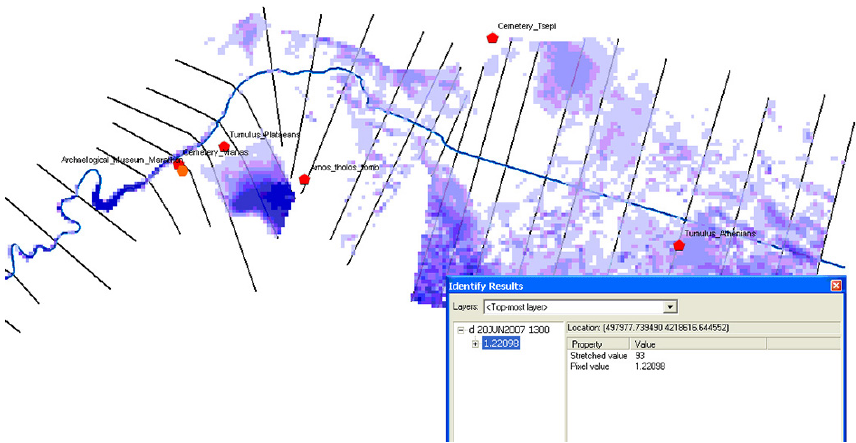
Figure 3. The flood hazard map of Rapentoza watershed for the scenario of T = 100 years (blue colour indicates the inundation area).